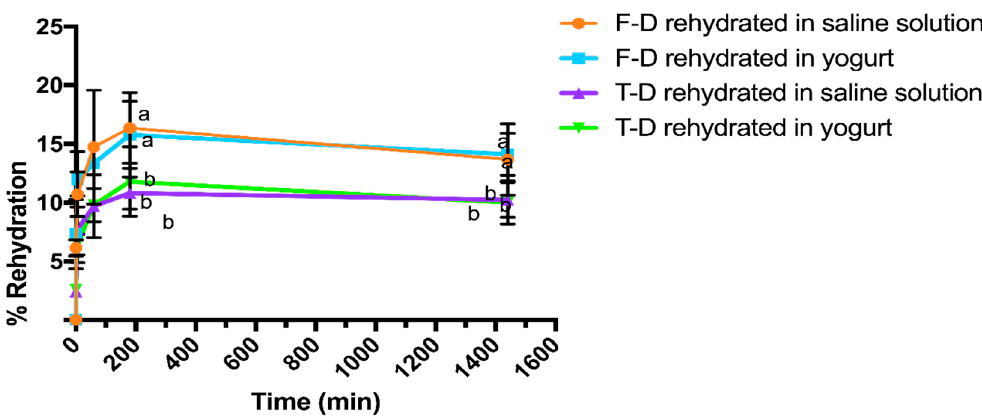
Figure 3. Rehydration capacity over time. Freeze- and thermal-dried capsules were placed in 0.9% NaCl solution (orange, purple, respectively) or in yogurt (light blue, green, respectively) and collected at specific sampling times (0, 0.25 min (15 s), 6 min, 60 min, 180 min, and 1440 min (24 h)) to evaluate their rehydration capacity, as described in the methods section. Bars represent standard deviation of three independent experiments. Different letters indicate significant differences ( p < 0.05).